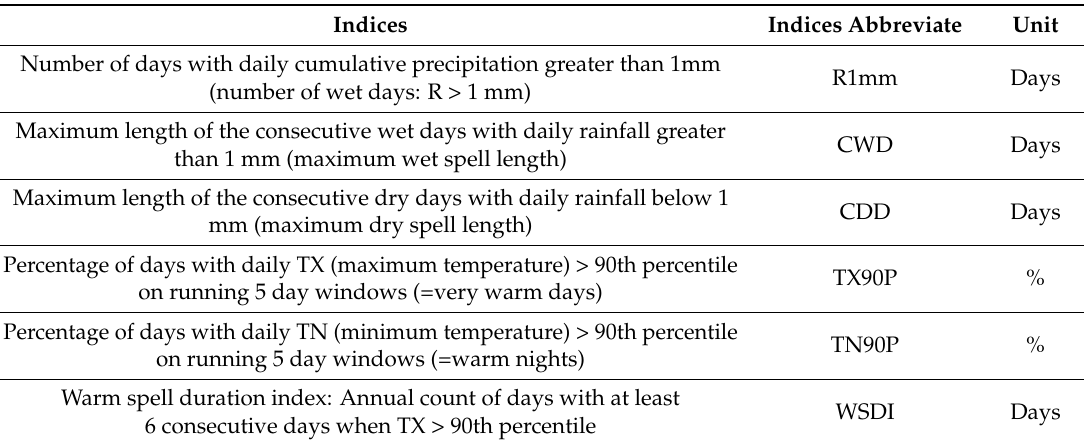
Table 1. Definition of climate indices